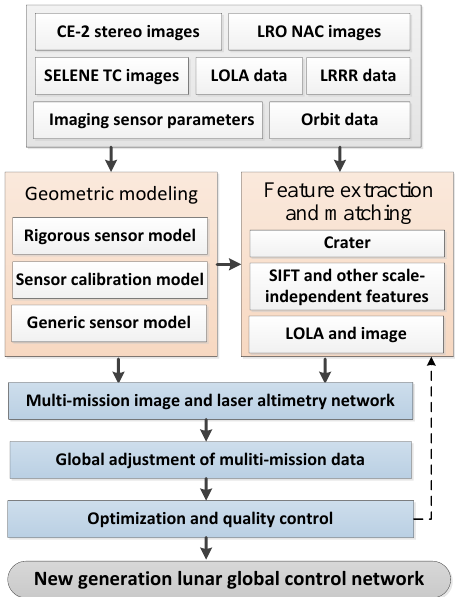
Figure 1. Overall technical